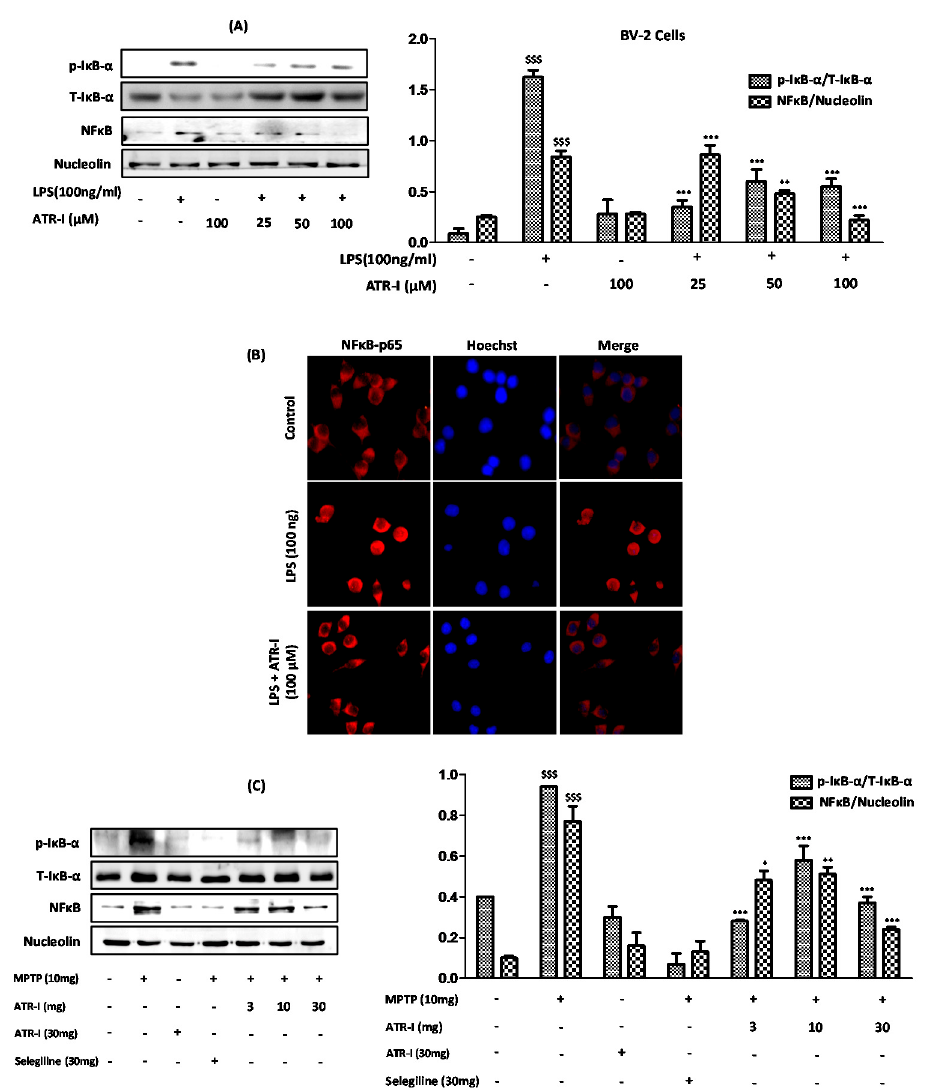
Figure 5. ( A ) Nuclear and whole-cell extracts ( n = 3) were prepared and analyzed by Western blot to asses ( A ) anti-p-I κ B- α and NF- κ B/p65; ( B ) The sub-cellular location of the NF κ B-p65 subunit was determined by an immunofluorescence assay ( n = 3). The total nuclear and whole-cell lysates ( n = 4) of the STR were tagged with ( C ) anti-p-I κ B- α and NF- κ B/p65. $$$ p < data compared with the vehicle group; * p , ** p , *** p < data compared with LPS and MPTP-treated groups.